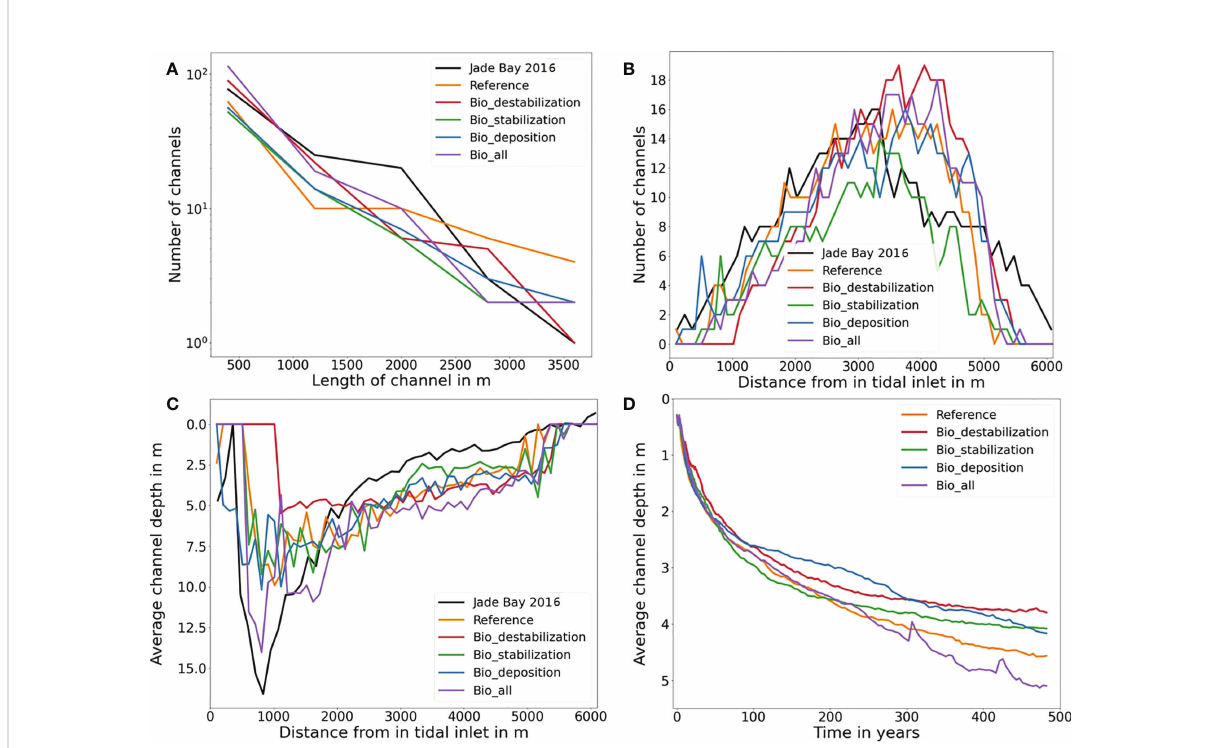
FIGURE 6 Statistics of channels in all simulations at year 500. (A) Number of channels in relation to the channel length. Note that the y-axis is in logarithmic scale. (B) Number of channels in relation to the distance from the inlet. (C) Average channel depth in relation to the distance from the inlet. (D) Change of average channel depth with simulation time. Note that statistics of channel in a natural tidal embayment (Jade Bay) are also included in (A – C)